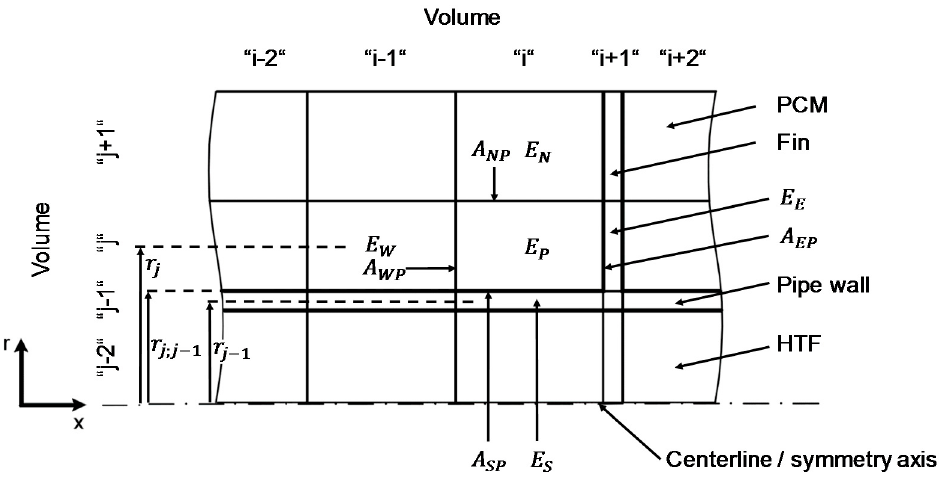
Figure 3. Section of the discretized two-dimensional model with exemplary declaration of elements, interfaces and radii.